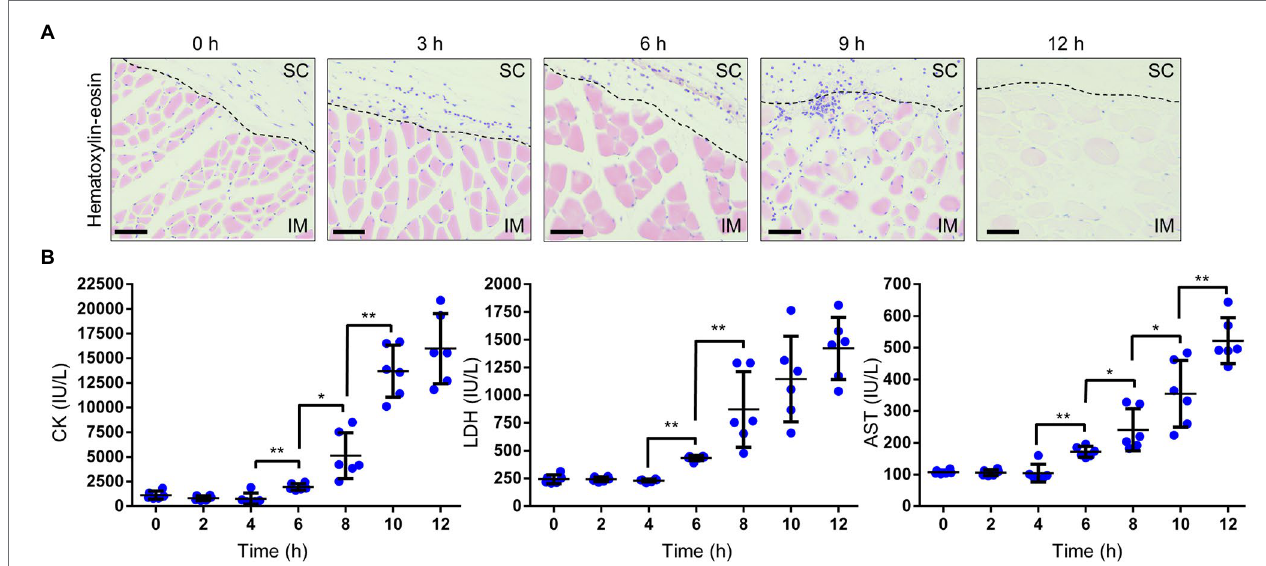
FIGURE 4 | Necrosis in muscle. (A) Hematoxylin–eosin-stained histopathology images of muscle beneath the infection sites in a mouse infected with Vibrio vulnificus (10 6 CFU/mouse). Scale bars: 25 μ m. SC, subcutaneous; IM, intramuscular; and the black dotted line is the border between SC and IM. (B) Measurement of creatine kinase (CK), lactate dehydrogenase (LDH), and aspartate aminotransferase (AST) levels in the sera of mice infected with V. vulnificus (10 6 CFU/mouse). Each symbol represents an individual mouse ( n = 6/group). Error bars indicate SEM. * p < 0.05, ** p < 0.01; Mann–Whitney U